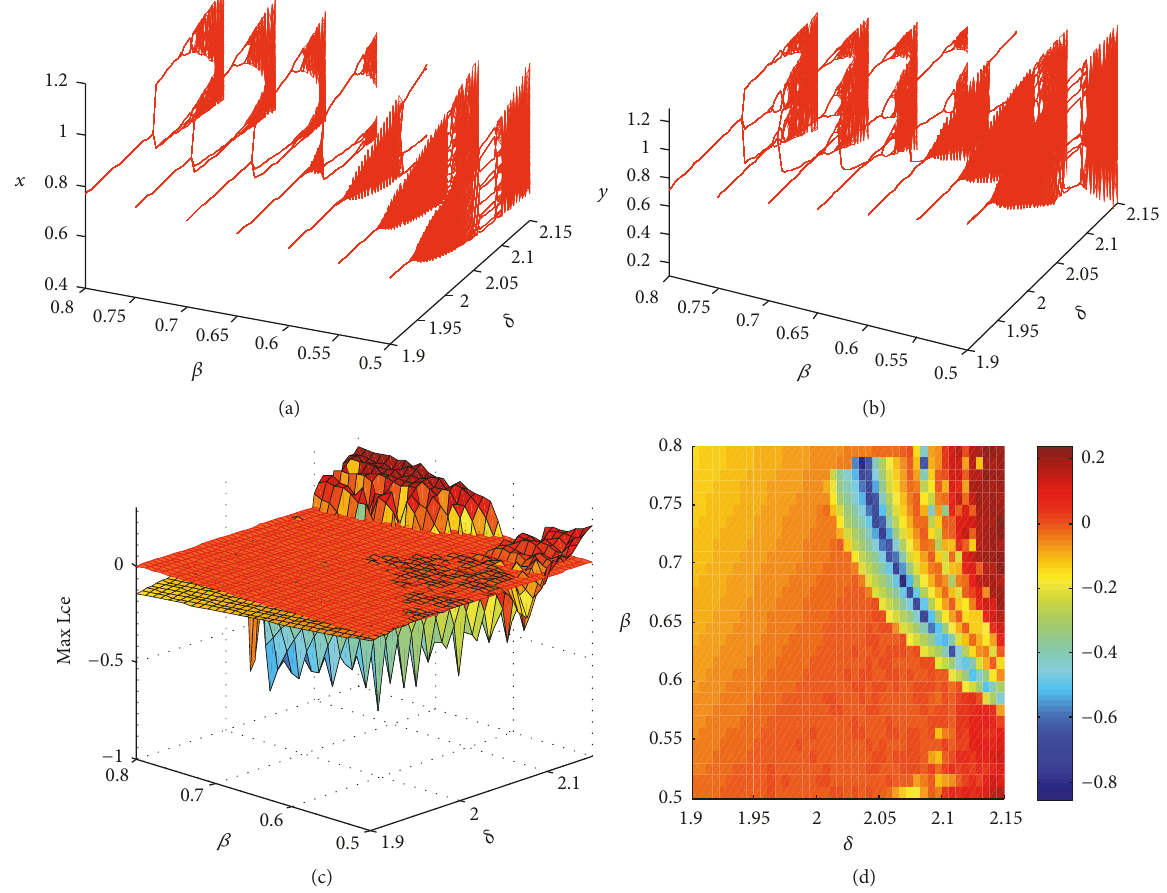
Figure 4: Diagnostic of system (4) for control parameters 𝛿 and 𝛽 . (a-b) Bifurcation for prey and predator covering 𝛿 ∈ [1.9,2.15] , 𝛽 = 0.5,0.55,0.6,0.65,0.7, 0.75,0.8 ∈ [0.5,0.8] in (𝛿 − 𝛽 − 𝑥) space and (𝛿 − 𝛽 − 𝑦) space. (c) The 3D view of maximum Lyapunov exponents related to (a-b). (d) The 2D projection onto (𝛿,𝛽) plane. Initial value (𝑥 0 ,𝑦 0 ) = (0.65,0.95)